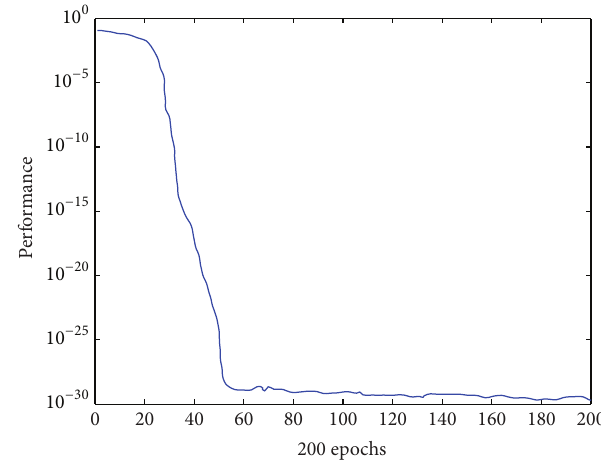
Figure 3: The RBFNN trained by